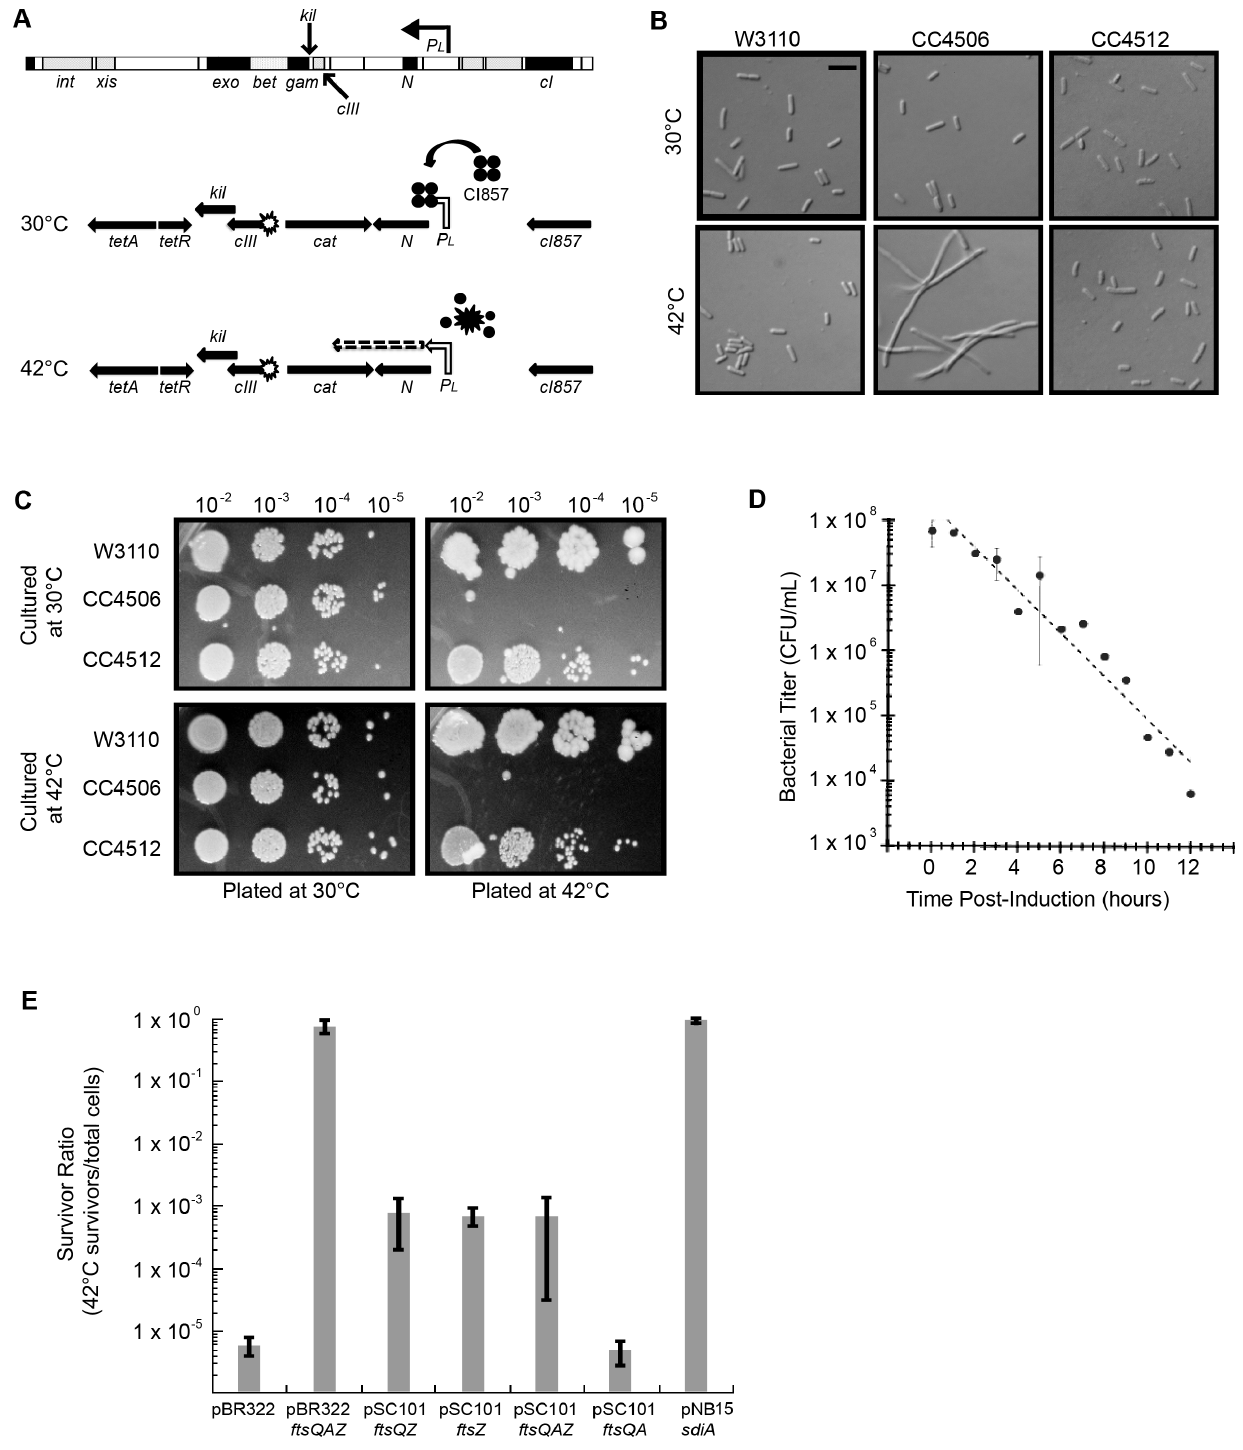
Figure 1. Induction of l kil interferes with E.coli cell division, but is suppressed by ftsZ overexpression. Strains: W3110=wild type, CC4506= kil + , CC4512= kil 2 . (A) Location of kil in the l genome and the defective prophage used for this study. The l kil gene overlaps cIII and gam as part of the operon under P L control (top schematic). P L expression of kil in the defective prophage (CC4506) is under control of the temperature- sensitive cI857 repressor, allowing repression at 30 u C (middle schematic) and expression at 42 u C (bottom schematic). (B) Induction of kil causes cell filamentation. Differential interference contrast (DIC) microscopy of E. coli strains back-diluted from a mid-log 30 u C culture to low optical density (OD 600 , 0.025) and grown to late-log in LB at 30 u C (top panels) or 42 u C (bottom panels). Scale bar=5 m m. (C) Induction of kil leads to a loss in cell viability. Serial spot dilutions of cells grown in LB at 30 u C (top panels) or 42 u C for 90 minutes (bottom panels) and then plated onto LB agar incubated at 30 u C (left panels) or 42 u C (right panels) overnight. (D) Prolonged induction of kil leads to an irreversible loss of viability. Bacterial titers of CC4506, expressed as colony-forming units (cfu) per mL, after indicated time of kil induction. Time points with error bars represent the average and standard